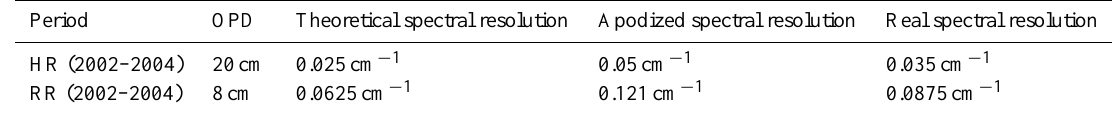
Table 1. Optical path differences and spectral resolutions of MIPAS measurements.